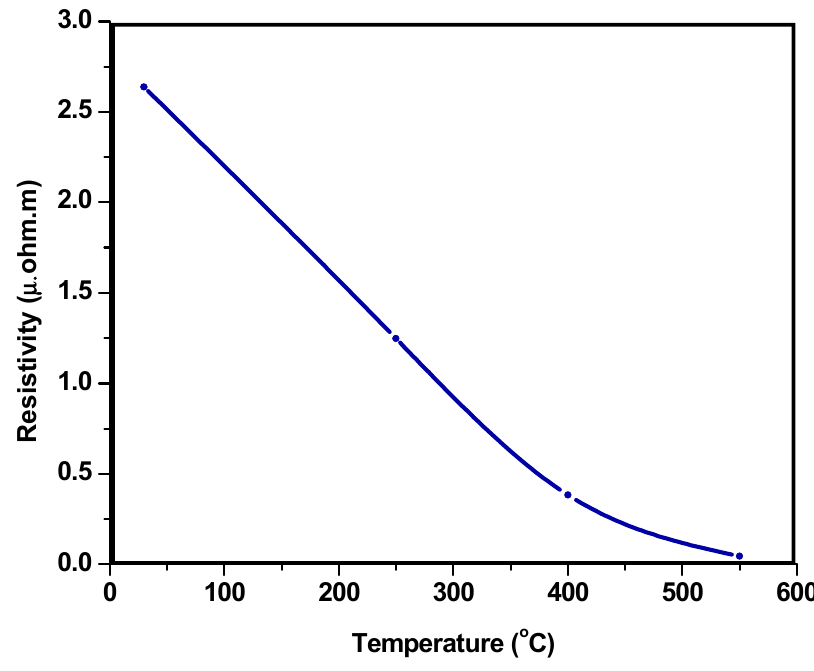
Figure 11. Behavior of resistivity with rise in temperature.